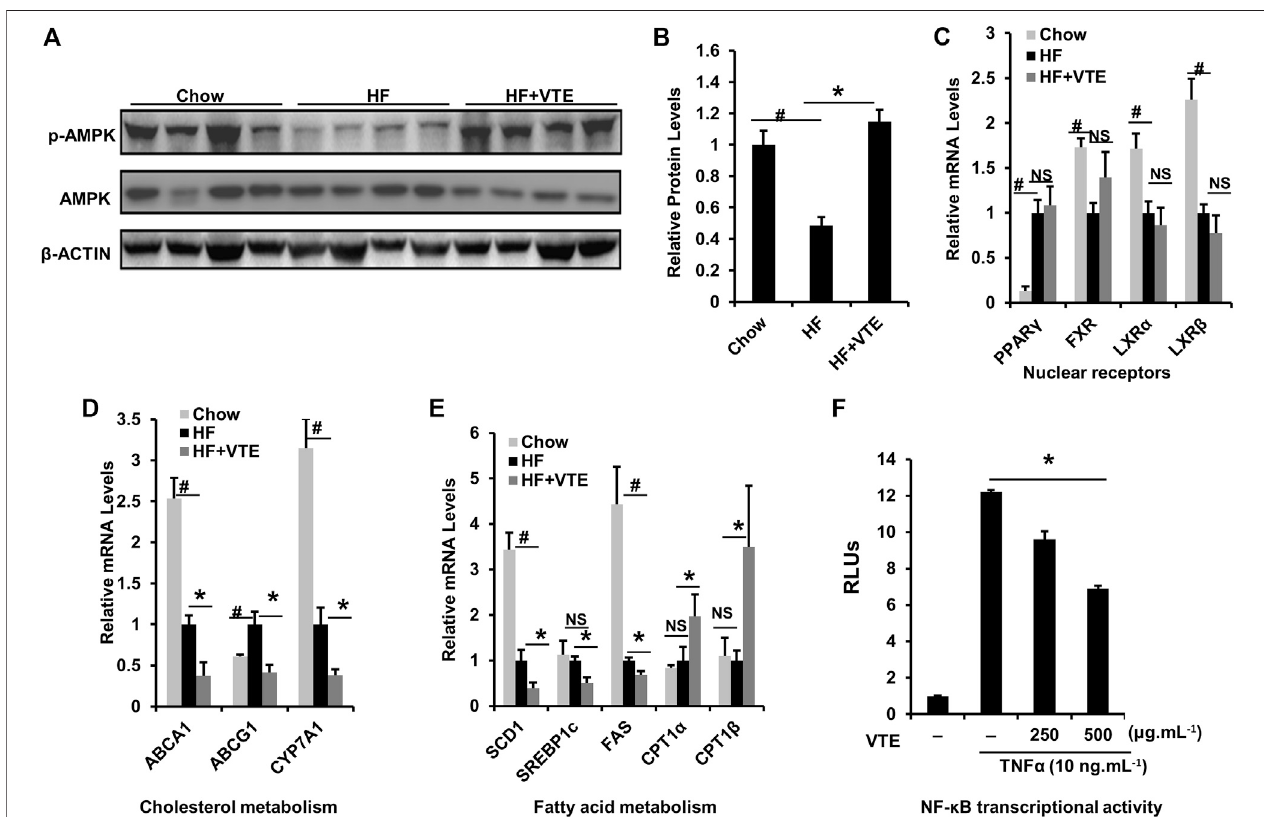
FIGURE 6 | VTE ameliorating NASH involves AMPK-LXR α signaling activation. Livers from chow group mice and DIO mice fed with an HFD supplemented with or without VTE (1 g 100g − 1 diet) for 6 weeks were harvested and subjected tomRNA and immunoblottinganalysis (A, B) Protein levels ofp-AMPK and AMPK inDIO mice wereanalysedbyimmunoblotting.Therelativeproteinlevelwasshown.AMPKwasusedasacontrolforproteinlevels; n (cid:2) 5pergroup (C – E) RelativemRNAexpression ofhepaticgenes; n (cid:2) 3 – 5pergroup. β -ACTINwasusedasaninternalcontrolfornormalizingthemRNAlevelsandproteinlevels. # p < 0.05,HFversusChowgroup. * p < 0.05, HF versus HF + VTE group. NS, no signi fi cance (F) Hepatocellular NF- κ B activity was analysed using a reporter assay. HepG2 cells were co-transfected with the p65 expression vector and NF- κ Bx3-LUC for 24 h and treated with the control (0.1% DMSO), VTE (250 and 500 μ g ml − 1 ) for another 18 h. Then cells were treated with TNF α (10 ng ml − 1 ) for an additional 6 h. The relative luciferase units (RLUs) were measured by comparison to renilla luciferase activities. The results represent three independent experiments, and data are statistically analysed as means ± SEM ( n (cid:2) 3). * p < 0.05, versus vehicle